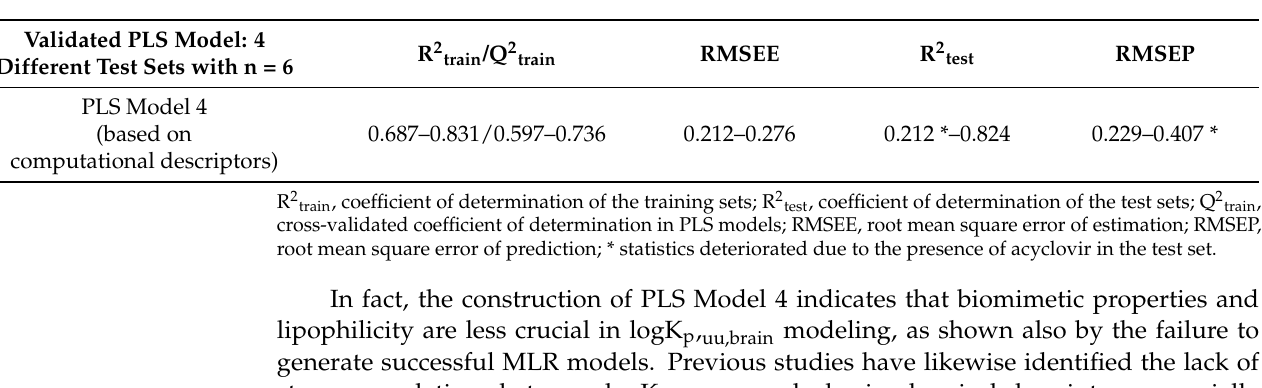
Table 1. Ranges of statistical values for training and external test sets used for validation of model 4 for logK p , uu,brain